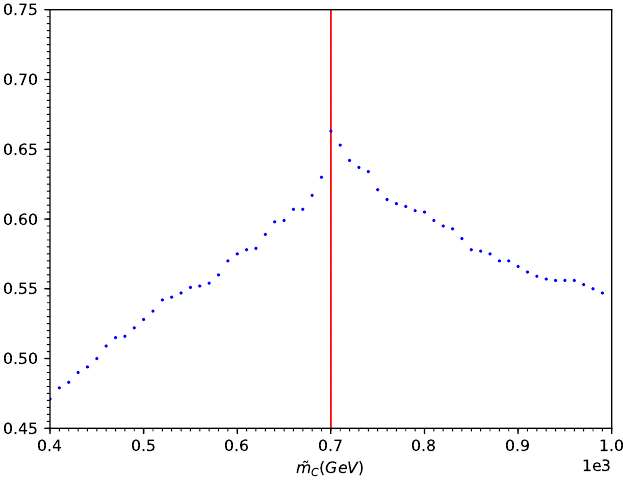
Figure 19 . Plot of the maximum density of degeneracy curves (in units of fraction/(10 GeV)) for di(cid:11)erent (cid:12)xed values of ~ m The peak value in the plot is observed at the true value of m red